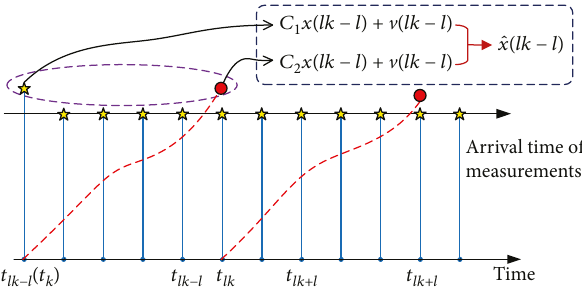
κ ∣ lk by using weighted fusion F